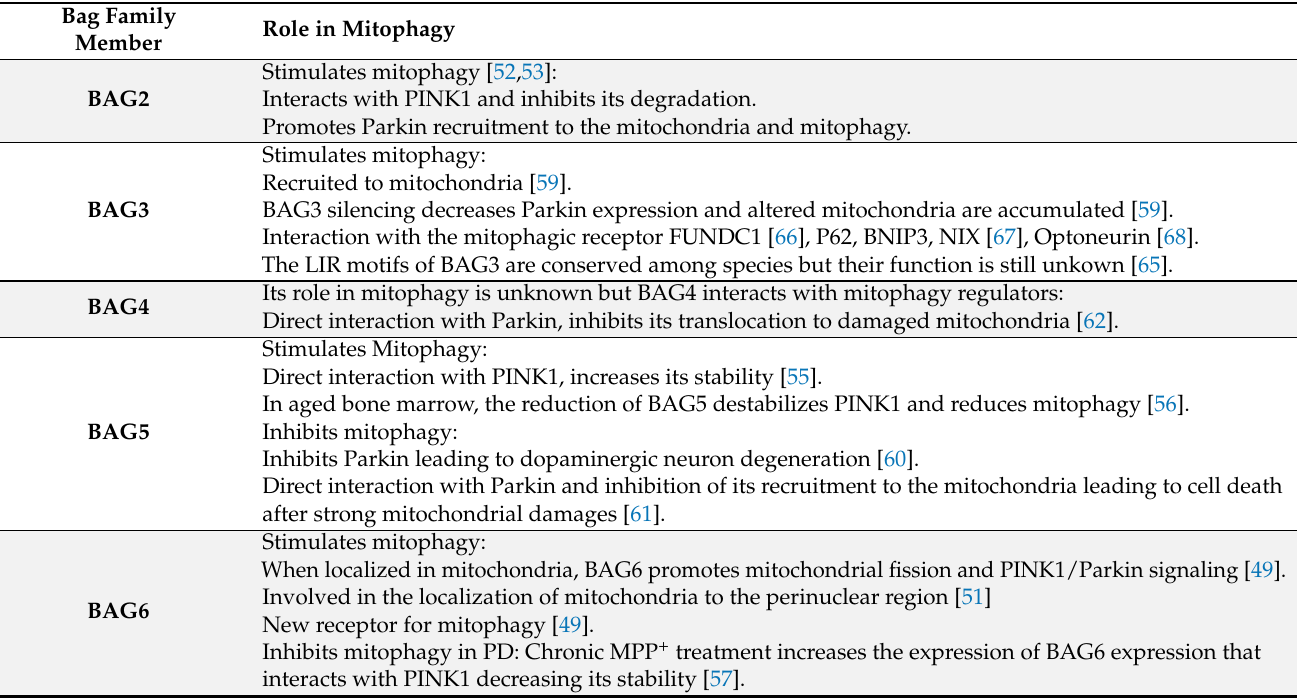
Table 2. Role of BAG family members in mitophagy